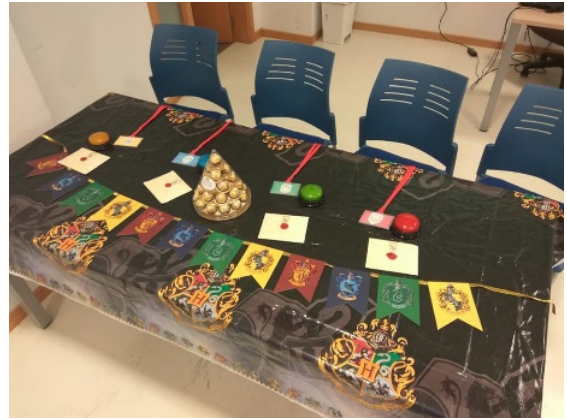
Figure 4. Activity Avada Kedavra.